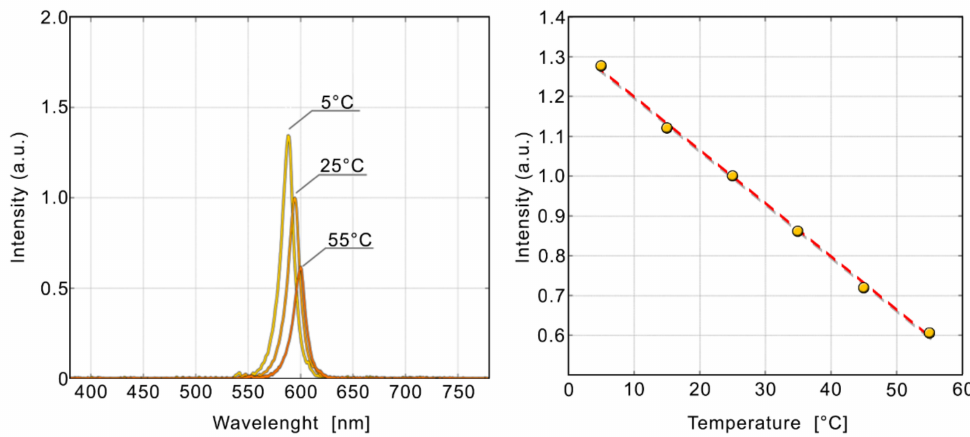
Figure 13. Characterization of the optical properties of the LY E6SF LED as the temperature varies. ( Left ) Emission spectrum vs. temperature. ( Right ) Emission efficiency vs. temperature.